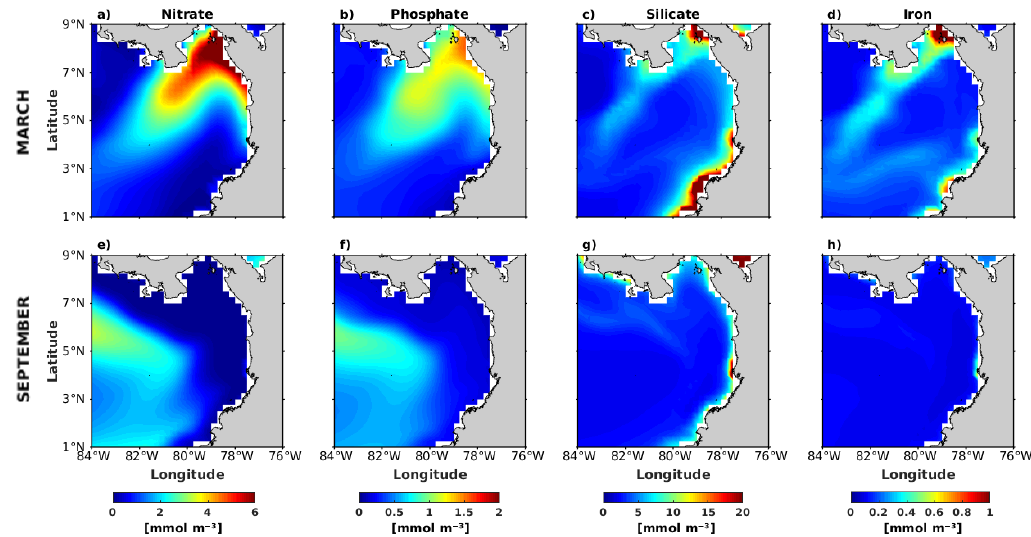
Figure 9. Climatology (2002–2016) of surface nutrient concentrations (in color scale) in the Panama Bight (PB) during March (top panels) and September (bottom panels). Red (blue) shading represents the regions with high (low) nutrient.